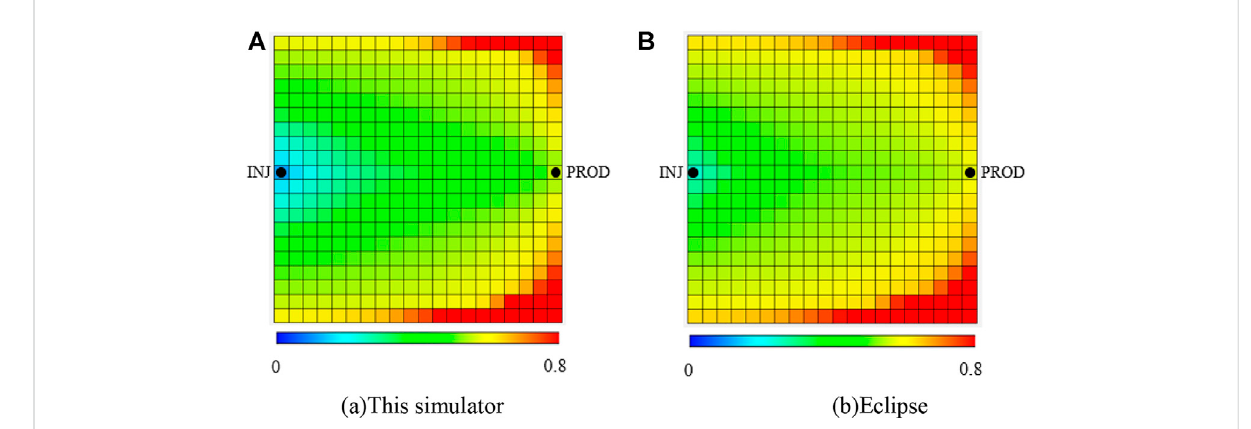
FIGURE 9 Oil saturation at the end of development.